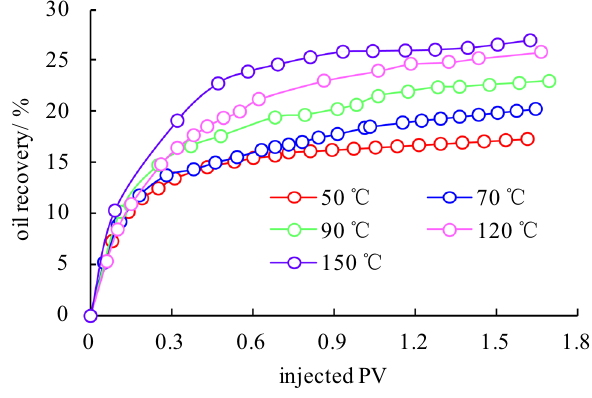
Fig. 1 Oil recovery varies with injected PVs at different